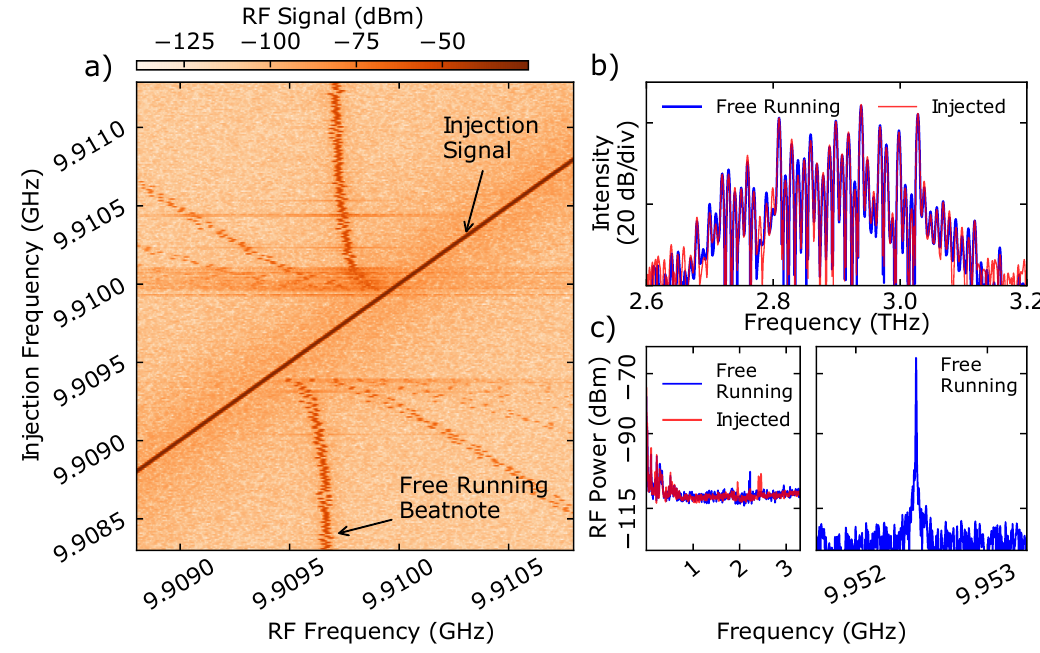
Figure 4. ( a ) Low power ( − 10 dBm at synthesizer) injection map at 80 K (714 mA, 9.69 V). Injection is via a neighbouring laser acting as an antenna without bias applied. ( b ) Spectra of the free running and injected laser at 80 K (590 mA, 9.12 V). Minor changes due to injection are observed in the spectrum. ( c ) Low-frequency components and narrow (<2 kHz) free running BN at 80K corresponding to the spectra in ( b ). Low-frequency components are unchanged and suggest that injection is not destabilizing the comb